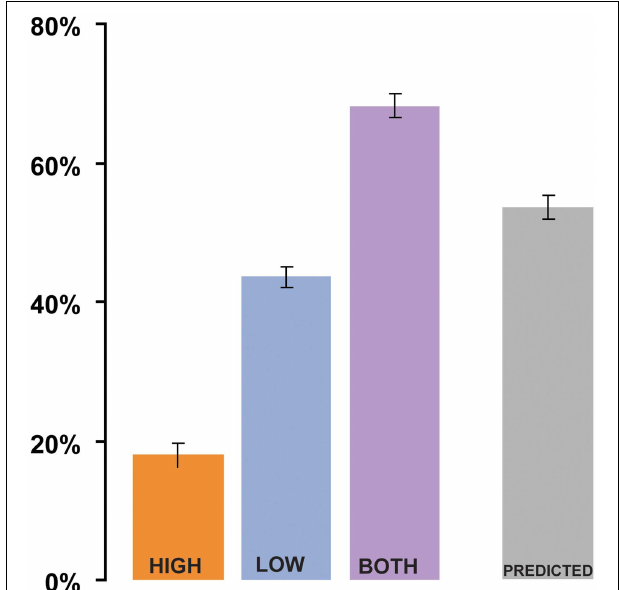
FIGURE 2 | Results of Experiment 1 (analysis by subjects). S high and S low , when presented separately (HIGH and LOW conditions, respectively), have low intelligibility. Dichotic presentation of S high with S low (BOTH) results in significantly better performance than what could be predicted from the combined performance on the HIGH and LOW conditions (“Linear combination”). Error bars are 1 std.